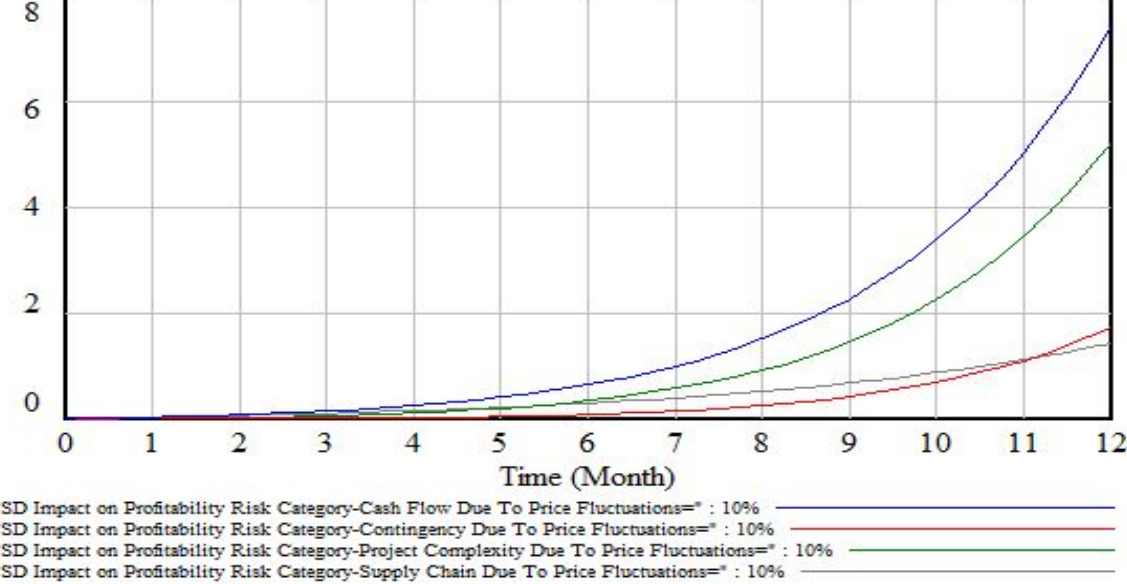
Figure 11. Dynamic integrated impacts on profitability risk categories over time (price fluctuations = 50%).